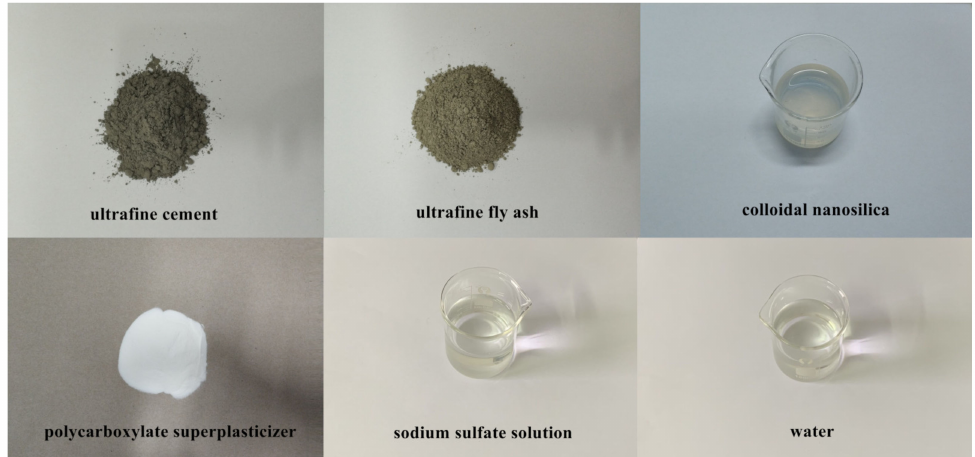
Figure 1. Composition materials of the designed UC-based slurry.